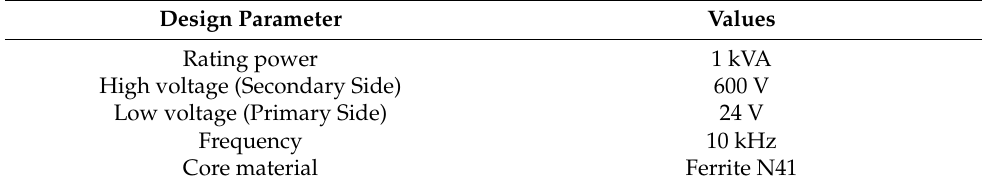
Table 3. Electrical Information for Toroidal Transformer